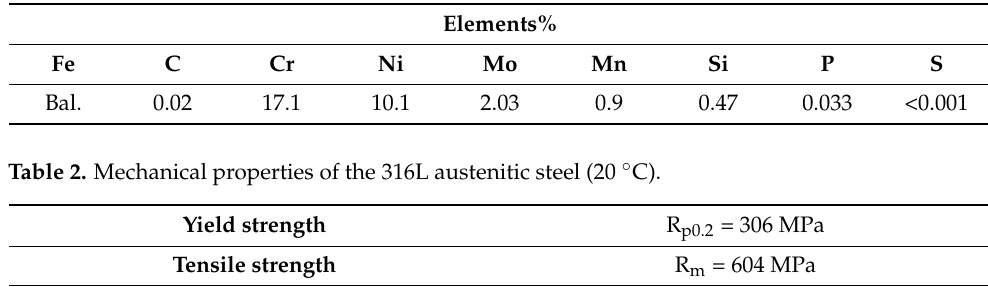
Table 1. Chemical composition of the 316L austenitic steel.